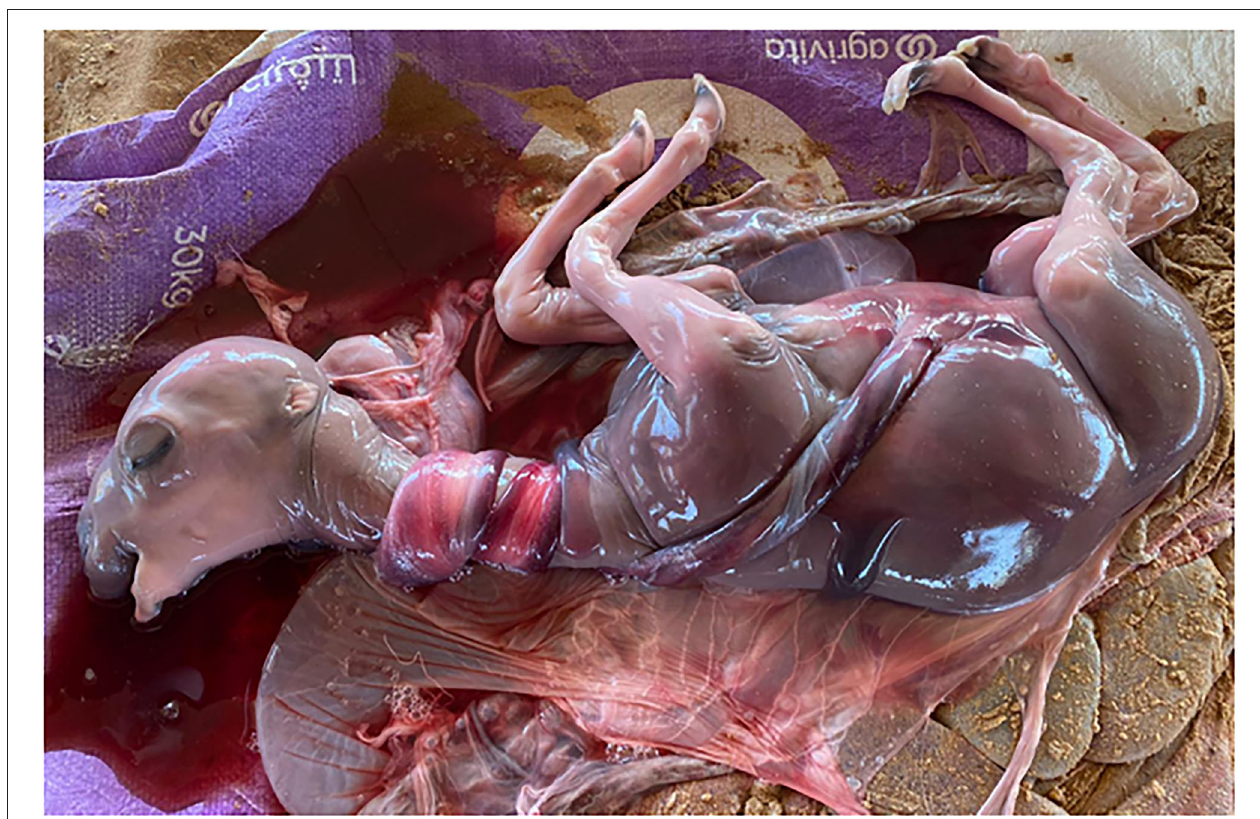
FIGURE 3 | Aborted fetus at 36 weeks of gestation. Fetal death may occur because of the double-looped nuchal